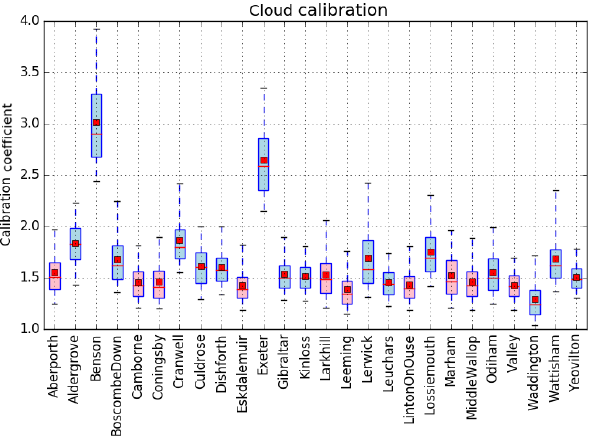
Figure 8. Calibration coefficient for each of the CL31 ceilome- ters in the UK Met Office network: 3 months of data (January– March 2015) have been used for each instrument. The number of suitable calibration profiles will be dependent on occurrences of cloud and, therefore, will vary for each instrument. The box outline represents 50% of the calibration profiles and the whiskers extend to include 95% of the profiles (outliers have been excluded from plot). The horizontal red line in the box shows the median calibra- tion coefficient and the smaller, filled box shows the mean. The box plot is shaded by firmware version as given by the ceilometer files on 1 January 2015: pink for version 202 and blue for versions 170 and